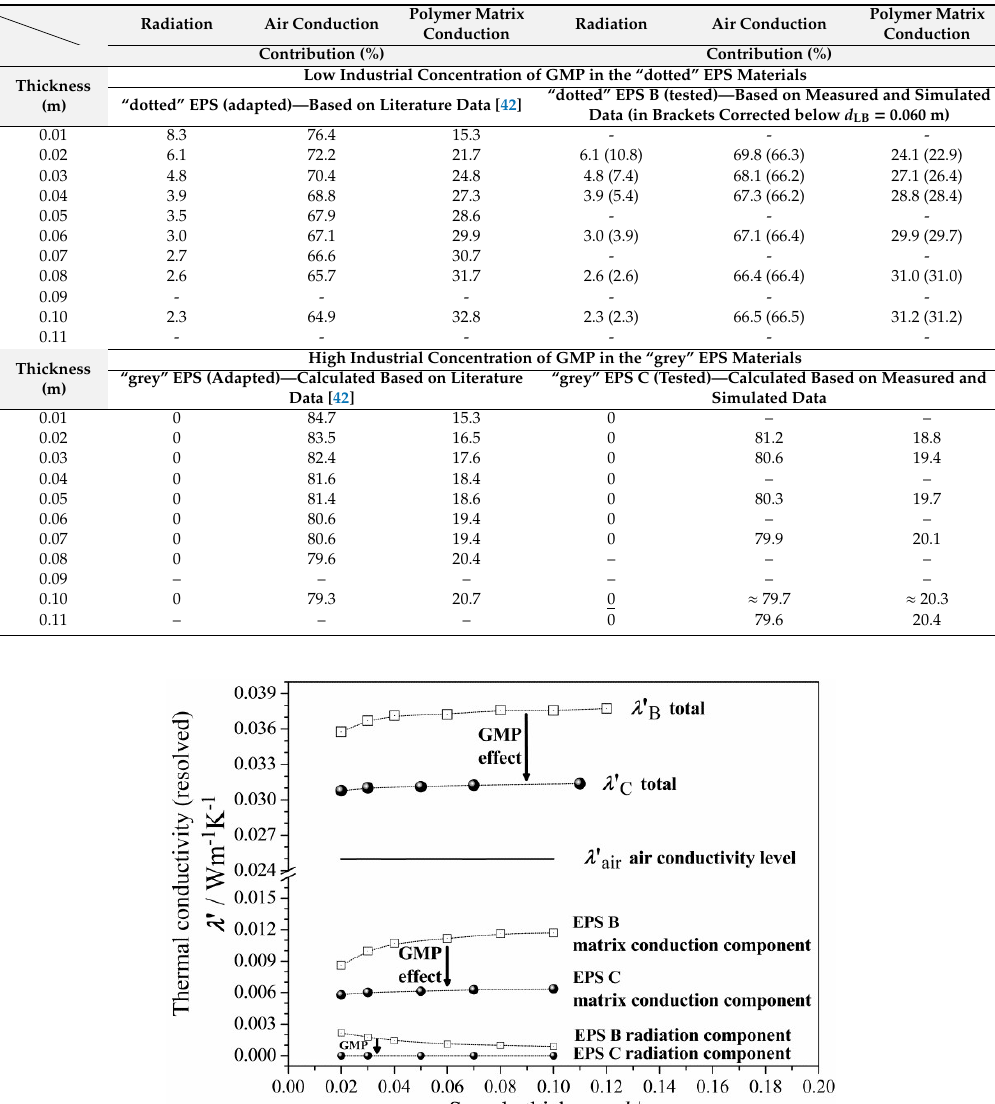
Table 5. Percentage contributions of the total thermal conductivity components (radiation, air conduction, and polymer matrix conduction) presented for the apparent λ (cid:48) (d) and corrected λ (d) (in brackets). The calculated results compare EPS B and C (tested) with the corresponding EPS (“dotted” and “grey”) from [42].